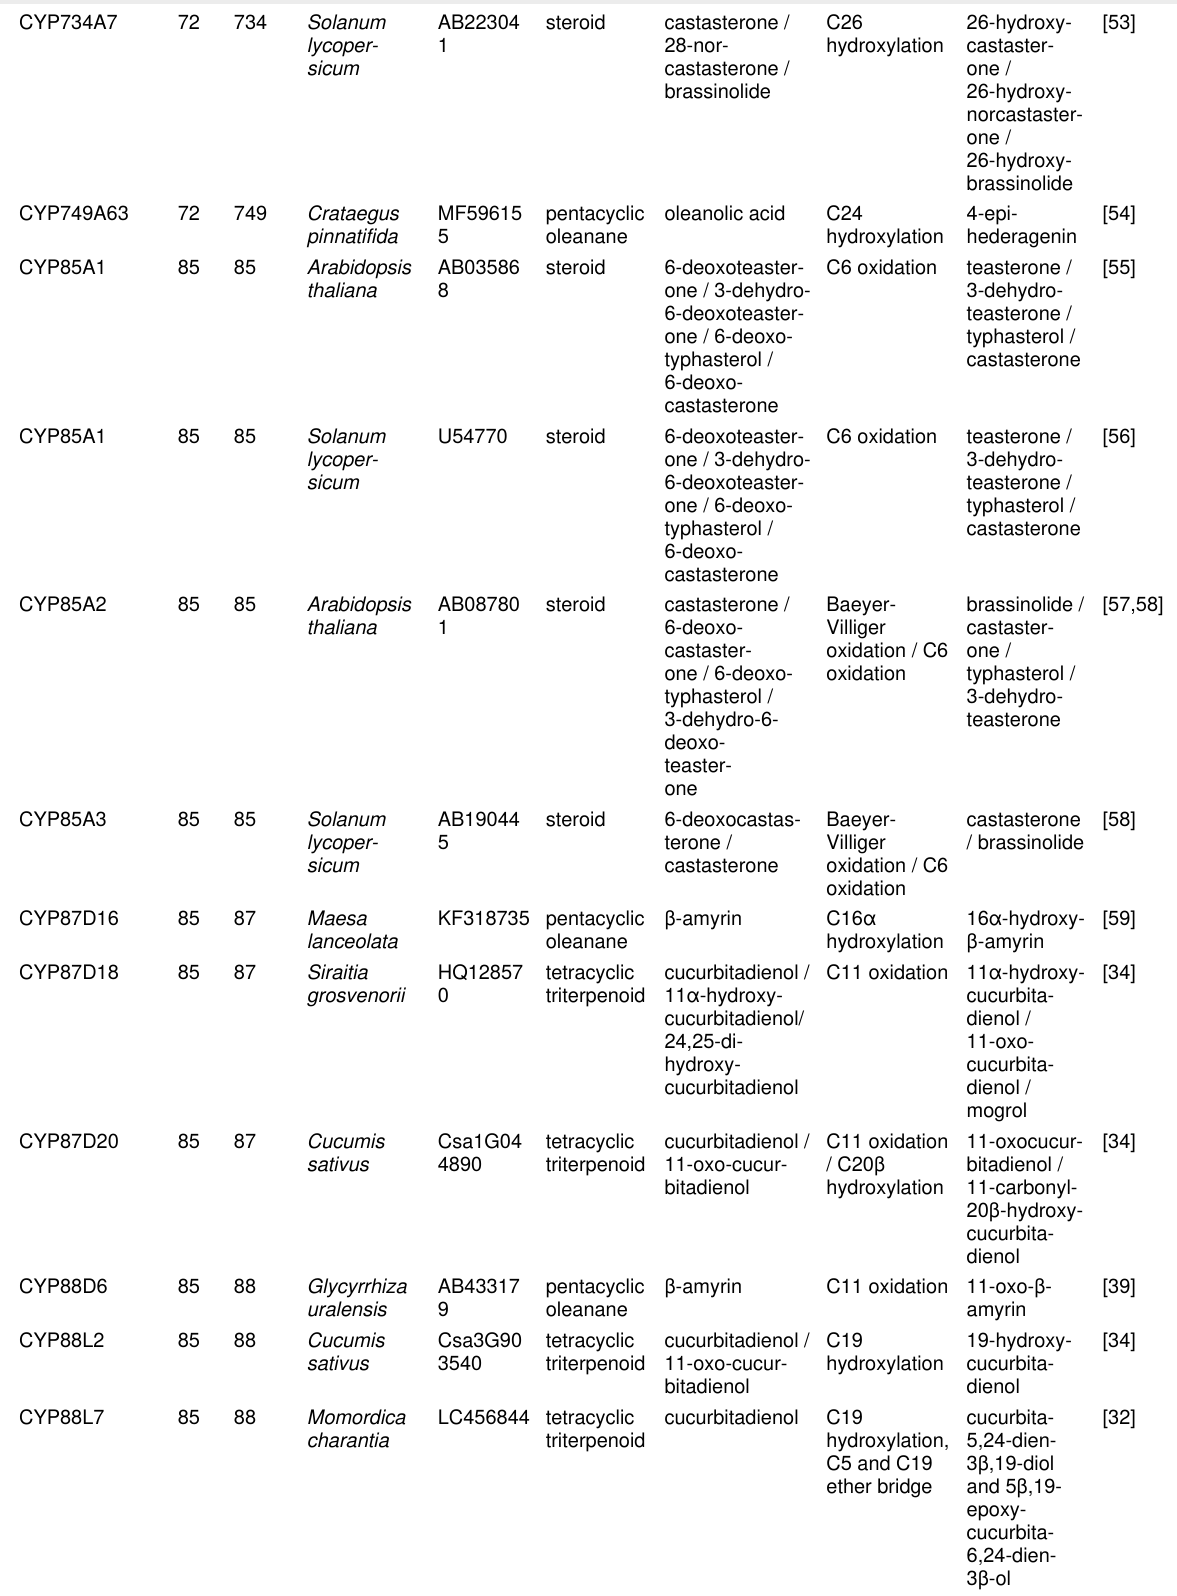
Table 1: List of characterised plant cytochrome P450 monooxygenases (CYPs) modifying triterpenoids or steroids. (continued)